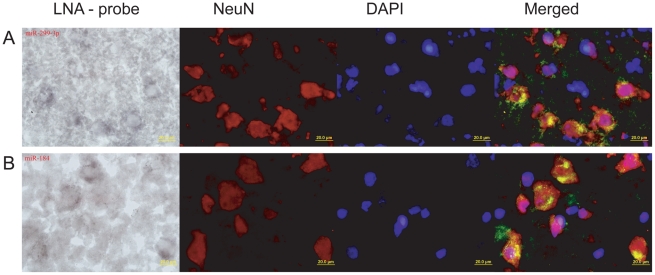

In situ staining of miR-184 and miR-299-3p in prefrontal cortex.(A) Rhesus macaque prefrontal cortex section hybridized with miR-299-3p LNA-probe (far left); anti-NeuN antibodies staining neuron nuclei (center left); DNA staining by DAPI (center right); and a merged image with miRNA staining shown in green (far right). (B) Human prefrontal cortex section hybridized with miR-184 LNA-probe (far left); anti-NeuN antibodies (center left); DAPI (center right); and a merged image (far right). All pictures were taken at 100x magnification. On the merged images, the miRNA hybridization signal was modified from its original one shown on the far left panel, by inverting and modifying to a green colour scale.